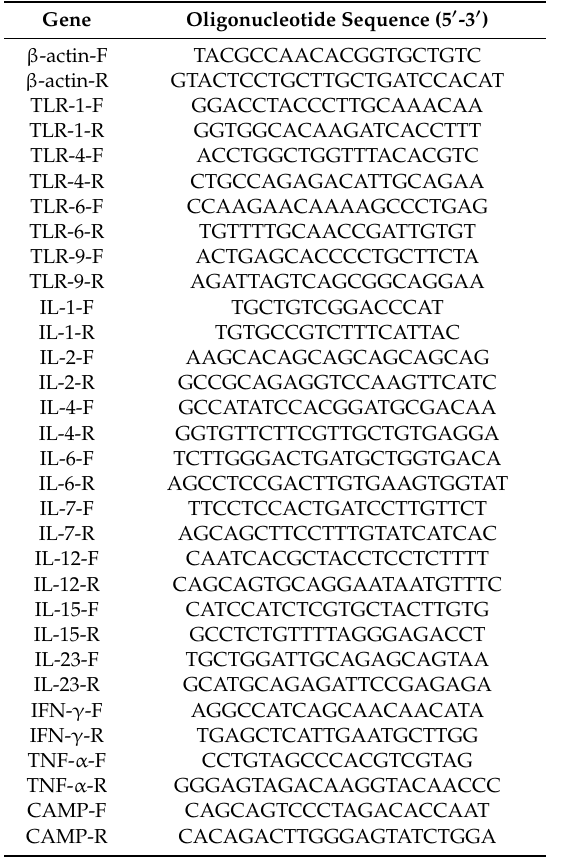
Table 2. The primers for RT-PCR. Gene Oligonucleotide Sequence (5 (cid:48) -3 (cid:48)